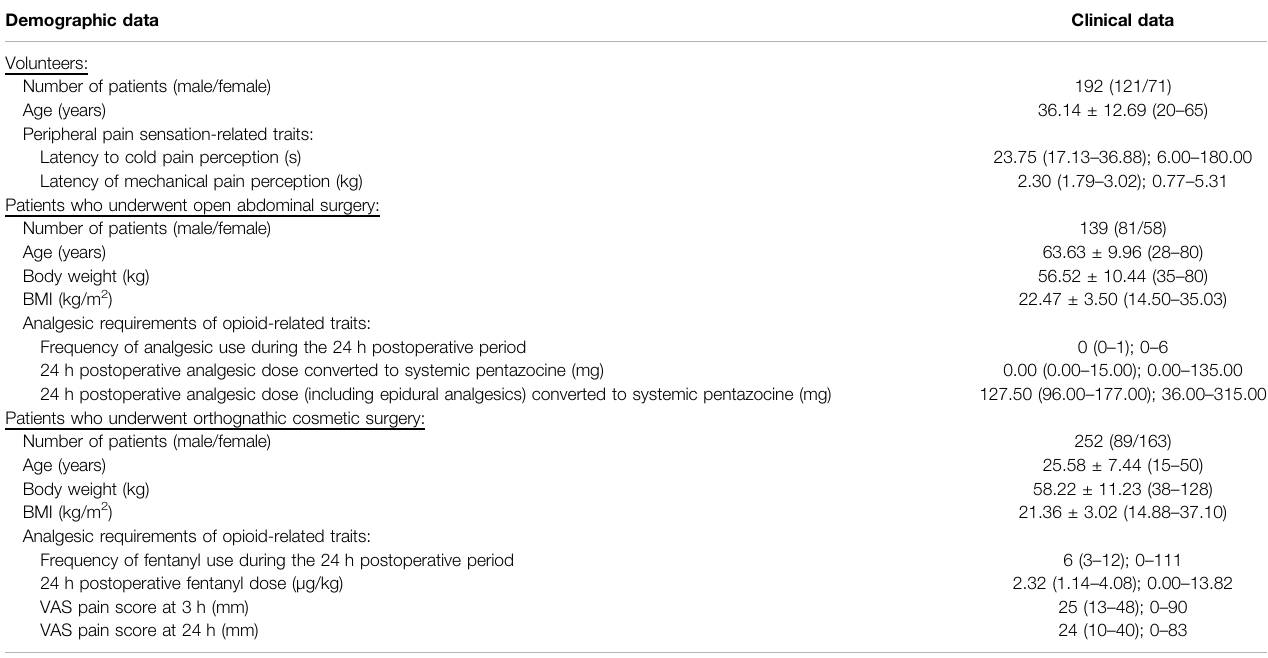
TABLE 1 | Patients ’ demographic and clinical